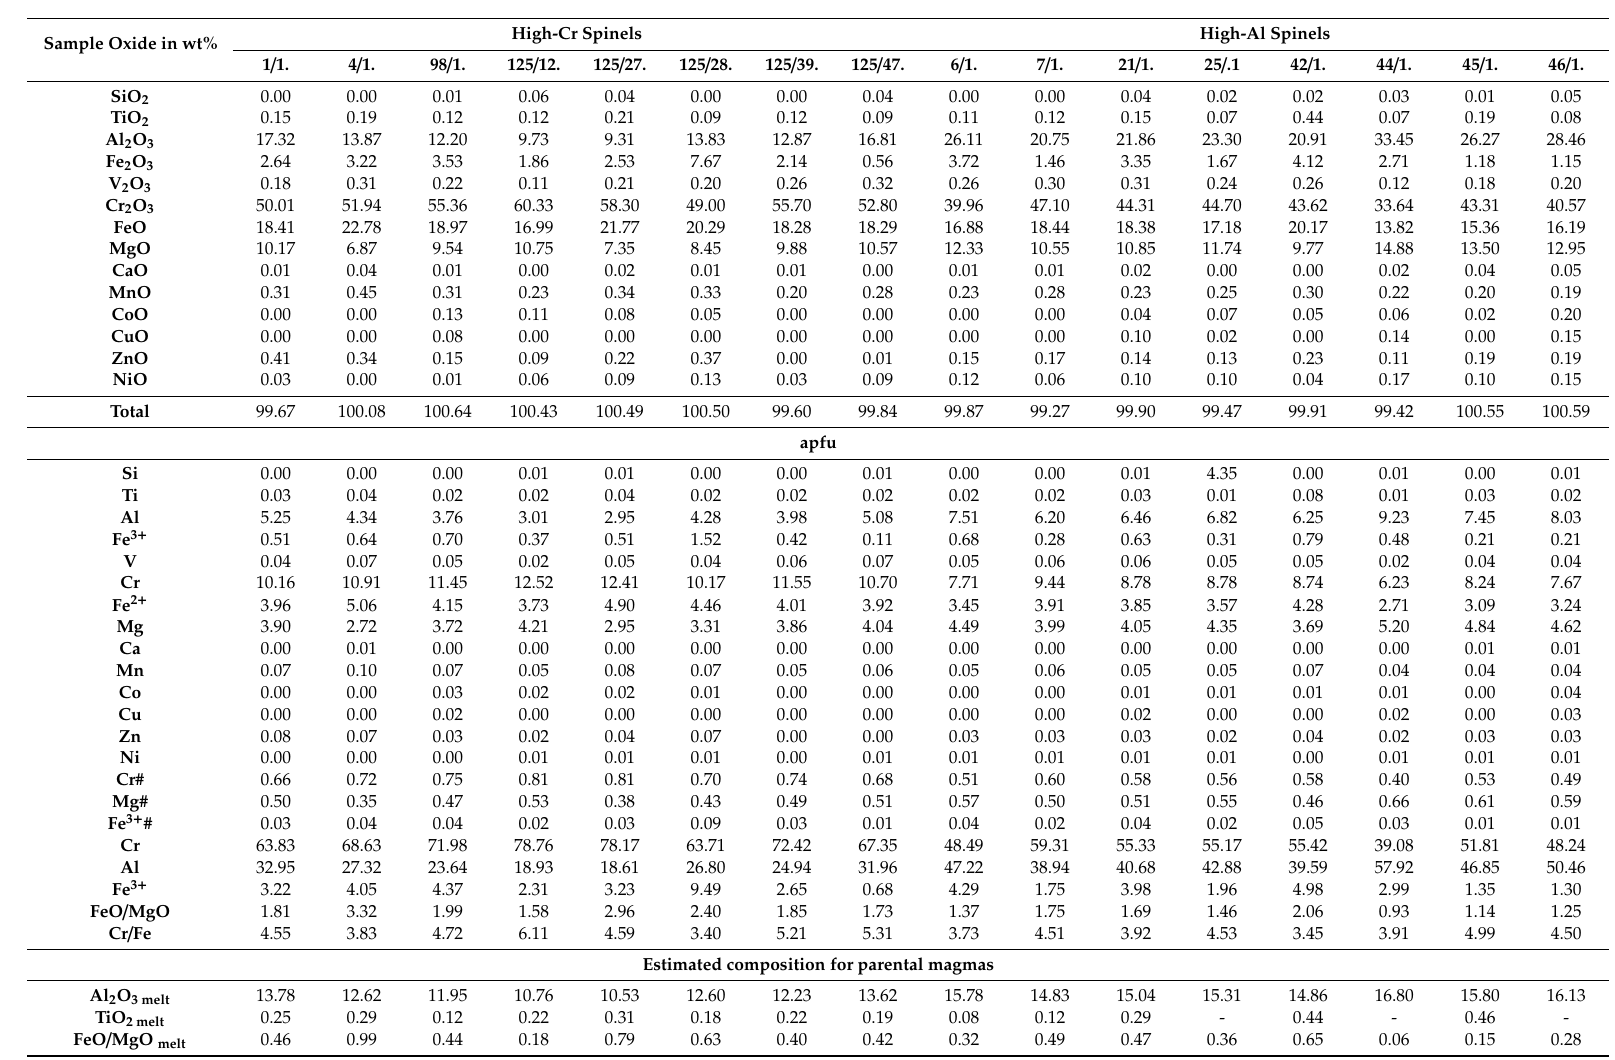
Table 5. Chemical composition of chromian spinel in wt%. EPMA (Electron probe microanalysis)